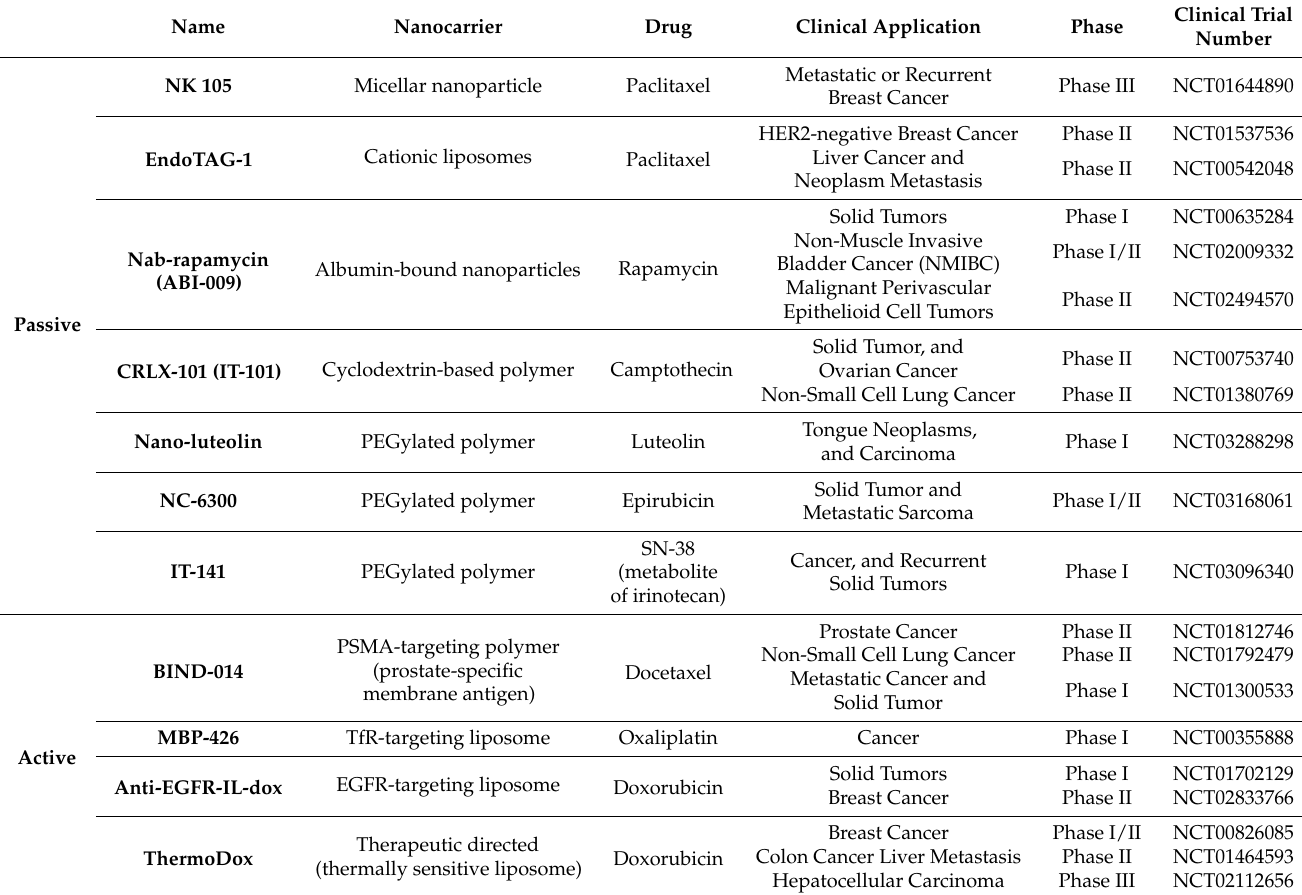
Table 5. Summary of current clinical trials of